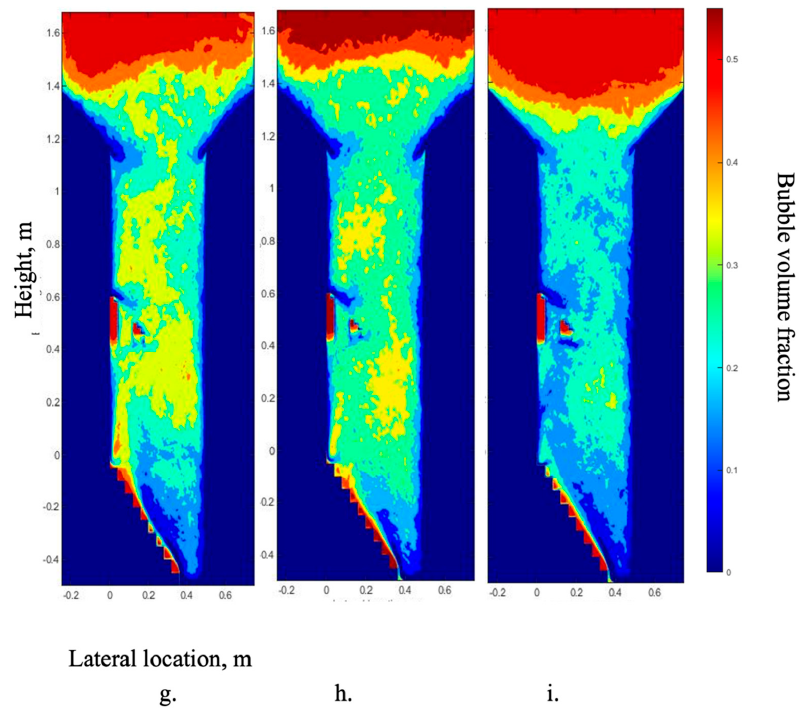
Figure 19. Bubble volume fraction contours in the entire fluidized bed reactor without and with baffle and fluxtube for different gas inlet configurations under the superficial gas velocity of 0.4 m/s, a. Upper, b. Even, c. Lower, d. Upper (Asymmetrical baffle), e. Even (Asymmetrical baffle), f. Lower (Asymmetrical baffle), g. Upper (Fluxtube), h. Even (Fluxtube), i. Lower (Fluxtube).